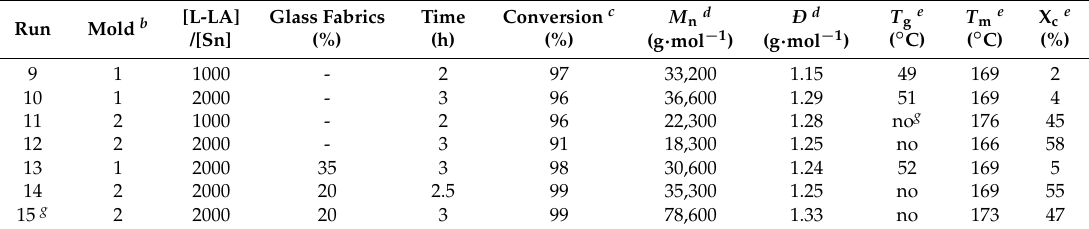
Table 2. Preparation of poly( L -lactide) (PLLA) matrices and PLLA composites with glass fabrics by RTM process a